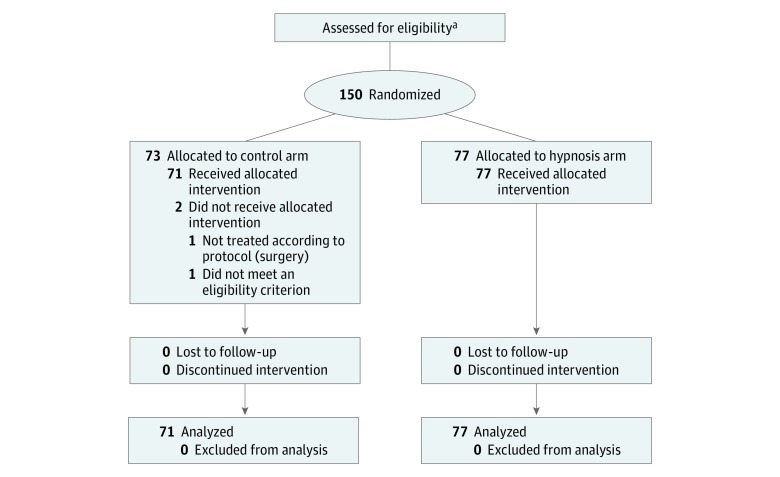
CONSORT Diagram of the StudyCONSORT indicates Consolidated Standards of Reporting Trials.aPatients screened were reported in 2 participating centers and not in the third (center 3).